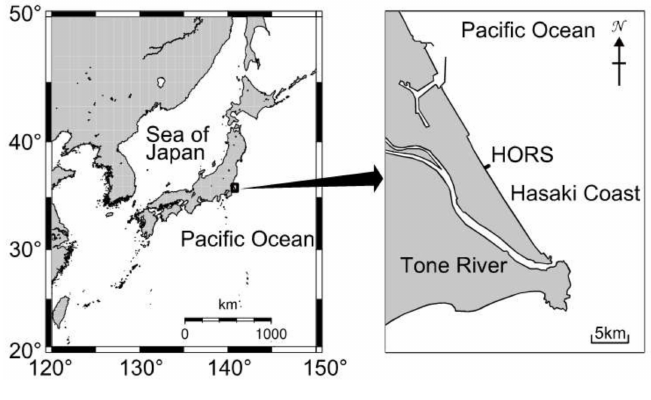
Figure 1. Location of study site.